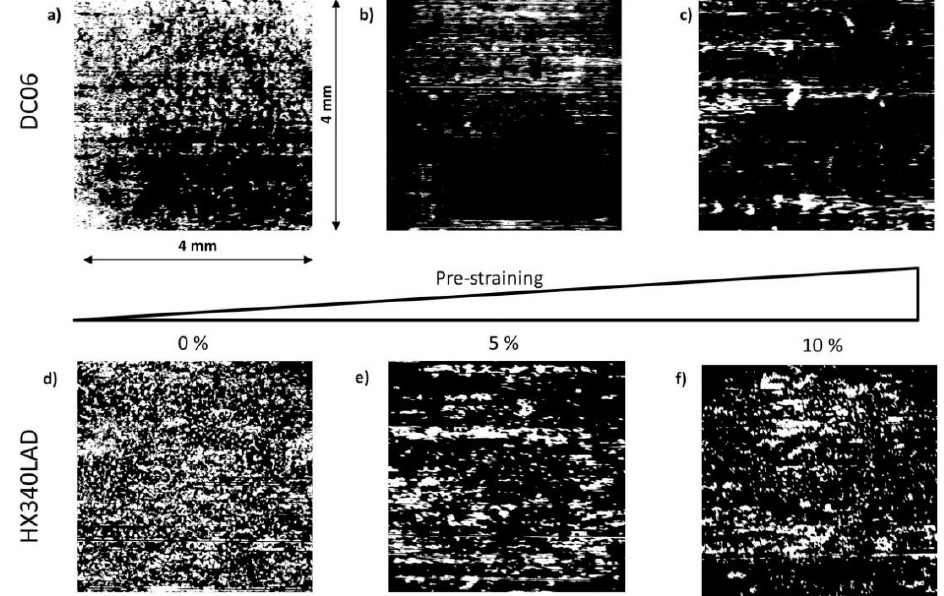
Figure 17. Real contact area (white) in a region of 4 mm × 4 mm of the test with 7.5 MPa contact stress and 50 mm/s sliding speed; ( a ) DC06 with 0% pre-straining; ( b ) DC06 with 5% pre-straining; ( c ) DC06 with 10% pre-straining; ( d ) HX340LAD with 0% pre-straining; ( e ) HX340LAD with 5% pre-straining; ( f ) HX340LAD with 100% pre-straining.